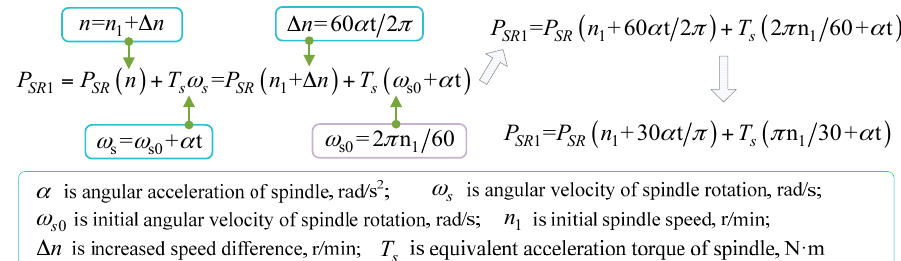
Figure 5. Theoretical derivation process of P SR 1